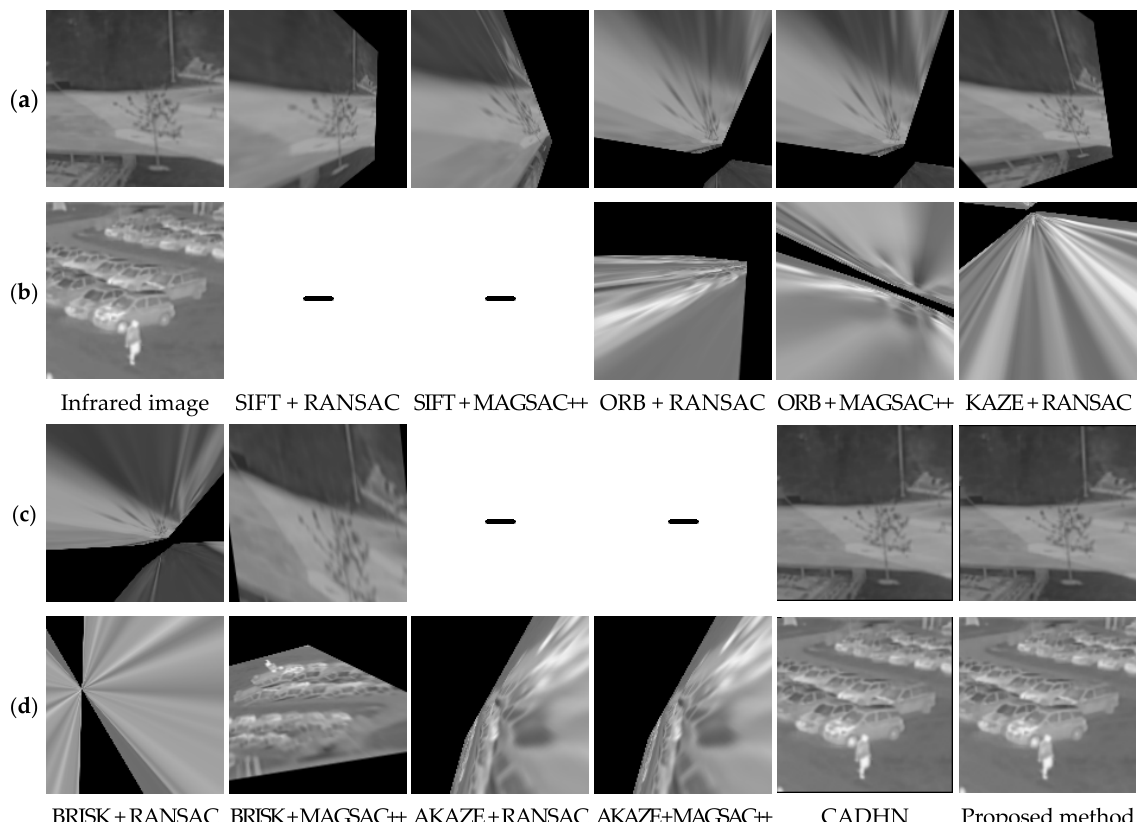
Figure 8. Comparison of warped images obtained by different methods in the two examples, as shown in ( a – d ). Except for CADHN [15], the other methods are feature-based methods.